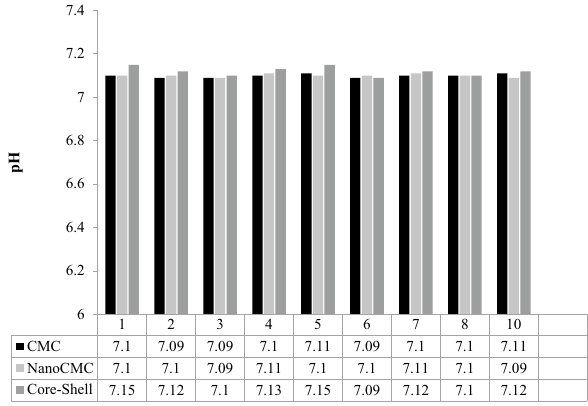
Fig. 14 Comparison of yield point of drilling fluid with bulk CMC, nanoCMC and core–shell nanocomposite additives